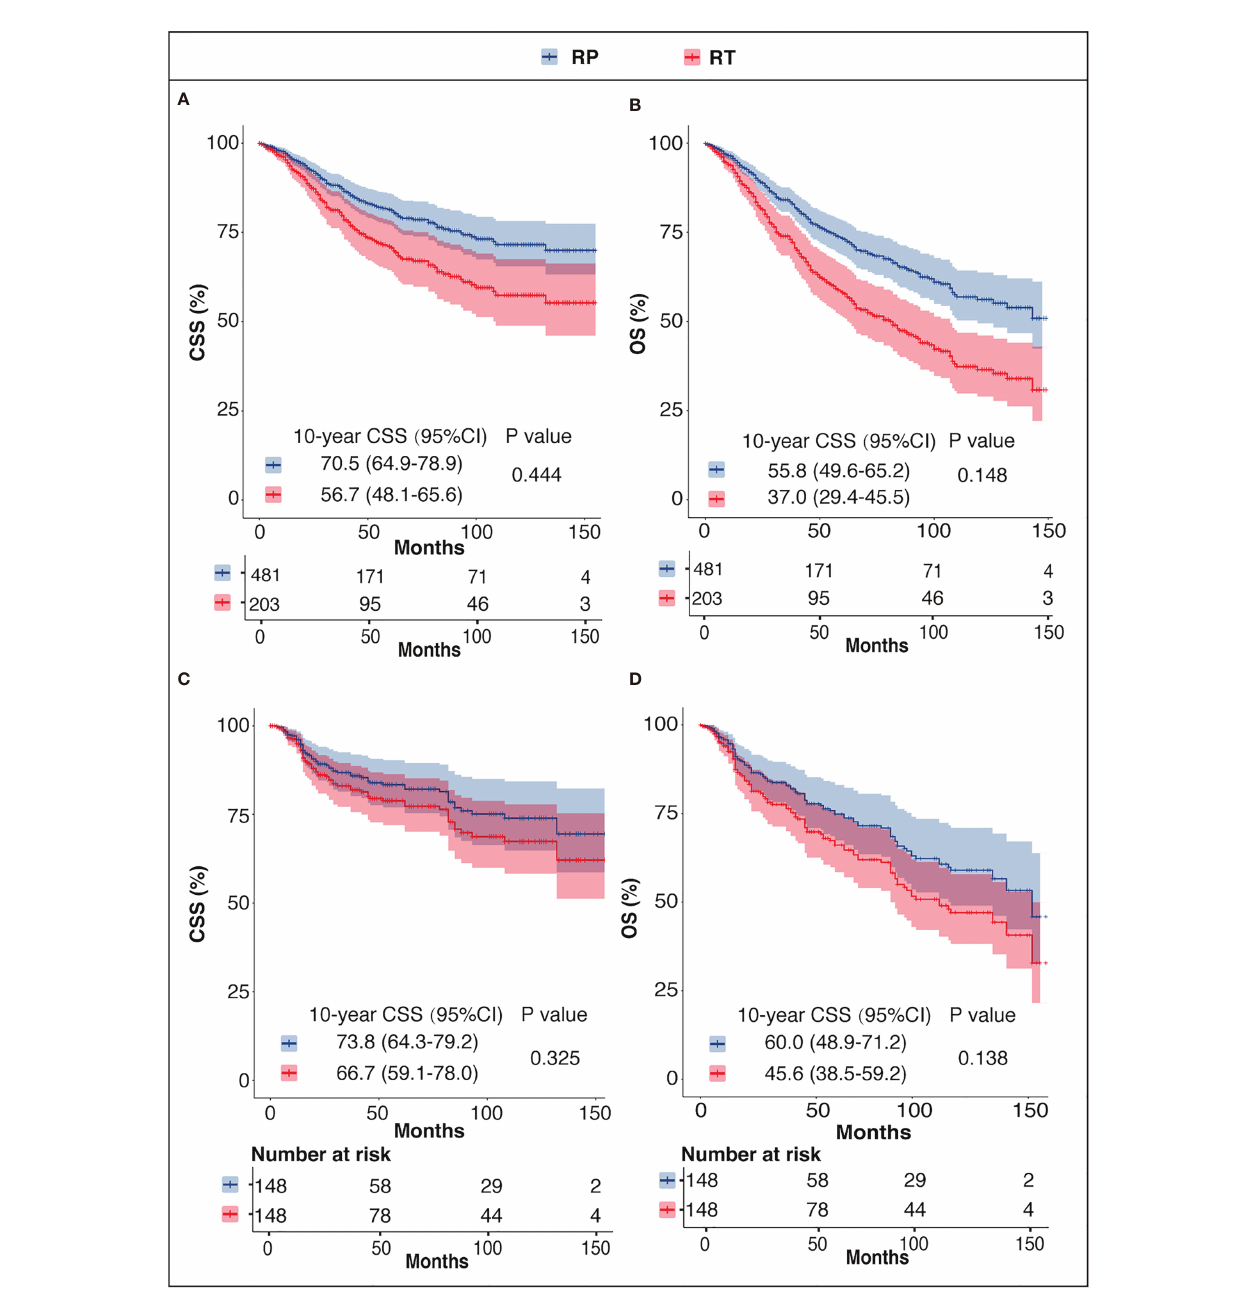
FIGURE 3 | CSS and OS of the RP and RT groups before PSM (A, B) and after PSM (C, D) . CSS , prostate cancer-speci fi c survival; OS , overall survival; RP , radical prostatectomy with or without external beam radiation therapy; RT , brachytherapy with or without external beam radiation